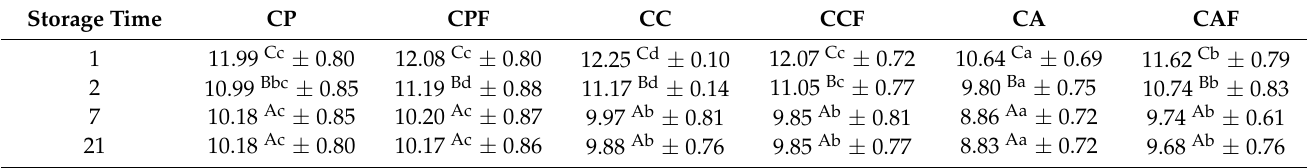
Table 4. Viable counts of probiotic bacteria in ice creams and ice creams mixture (log cfu g − 1 ). Storage Time CP